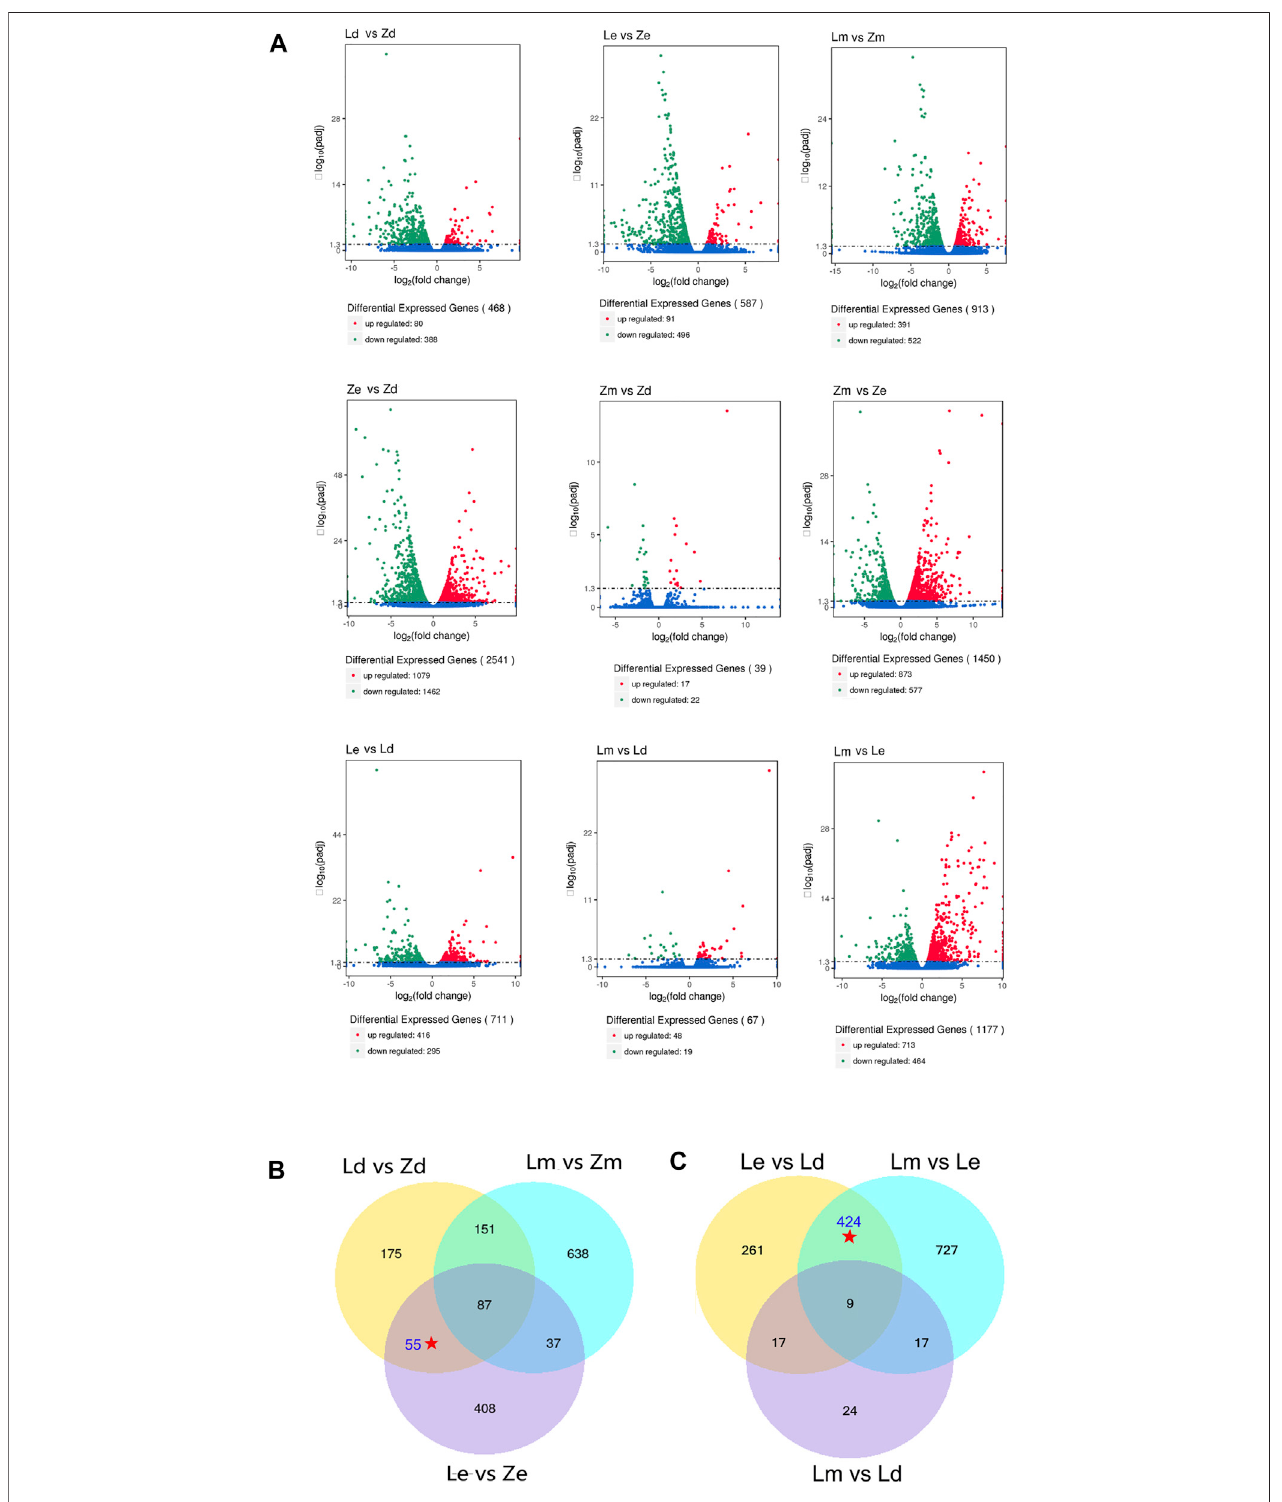
FIGURE 2 | Analysis for differentially expressed genes (DEGs) among different combinations of eggplant peel samples collected from under the calyx (Le and Ze), theapex(LdandZd),andthemiddlesurface(LmandZm)ofeggplantfruitfromlinesLandZ,respectively. (A) TheDEGnumbersamongdifferentcomparisons. (B) Venn diagram showing overlapping DEGs in comparisons of the same regions between the wild type and mutant. Le , peel under the calyx of L; Ze , peel under the calyx of Z; Lm , the peel on the middle parts of L; Zm , the peel on the middle parts of Z; Ld , the peel on apex parts of L; Zd , the peel on apex parts of Z. (C) Venn diagram showingoverlappingDEGsincomparisonsofpeelsamplesfromdifferentpartsofLlineeggplantfruit. Le ,peelunderthecalyxofL; Ze ,peelunderthecalyxofZ; Lm ,the peel on the middle parts of L; Zm , the peel on the middle parts of Z; Ld , the peel on apex parts of L; Zd , the peel on apex parts of Z.